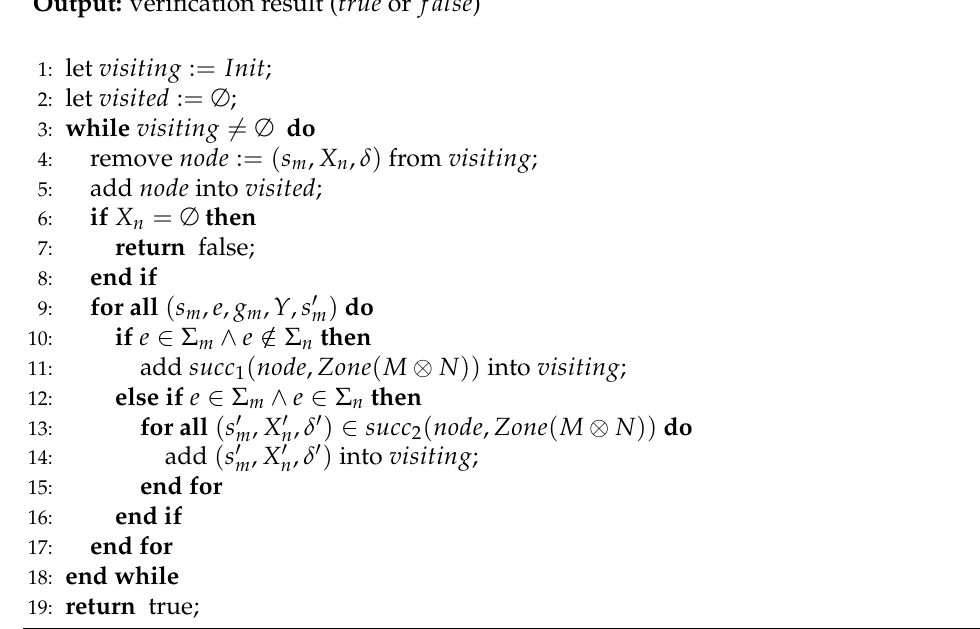
Algorithm 1 Timed Automata Language Inclusion Checking Algorithm with Concerned